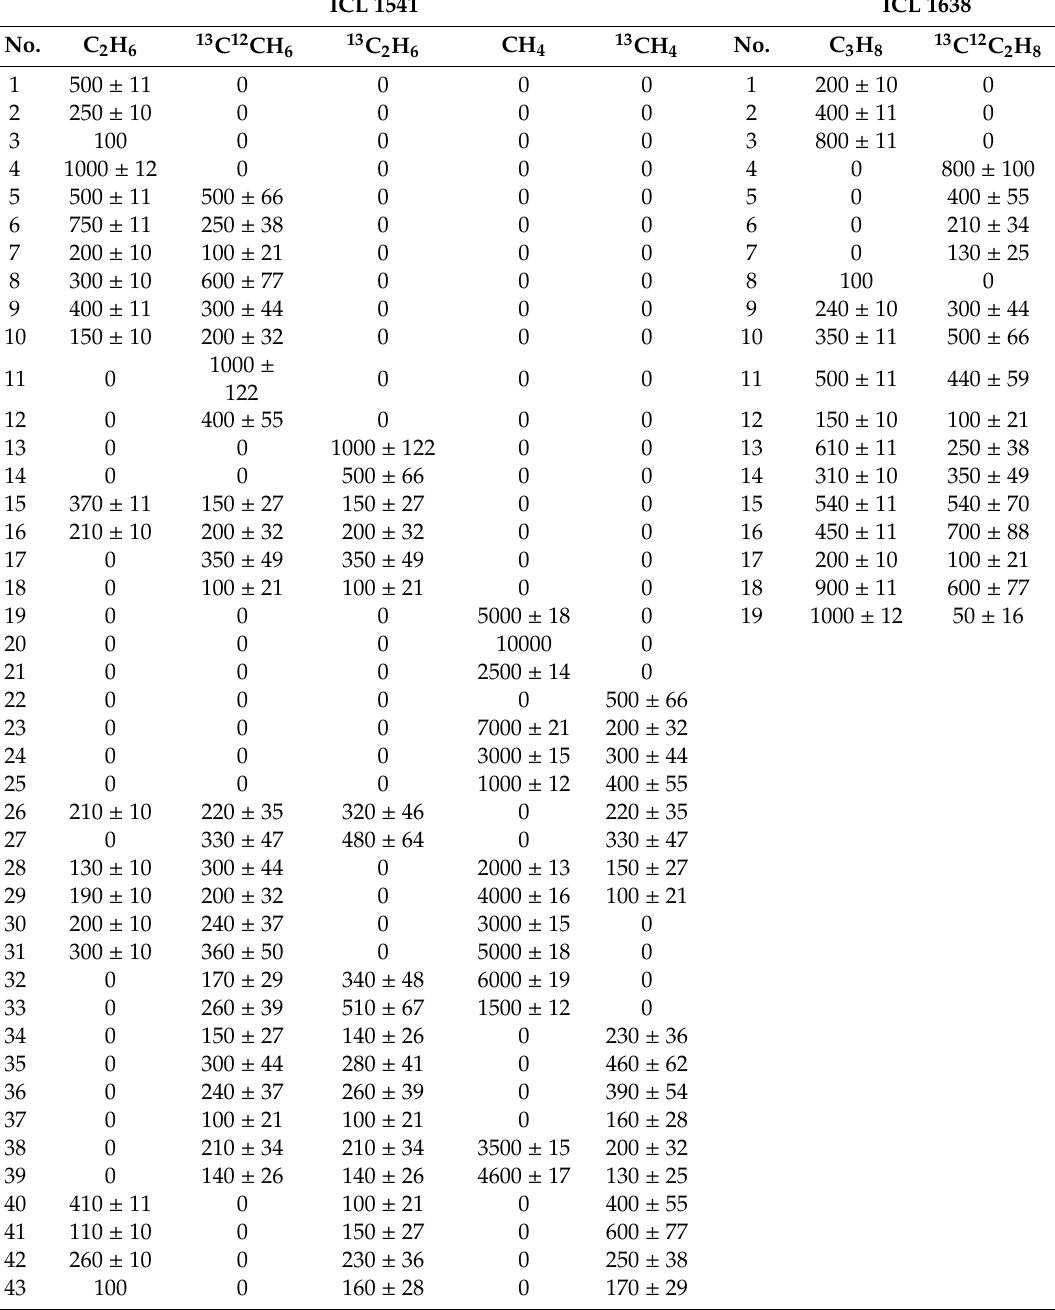
Table A1. Hydrocarbon concentrations of the gas mixtures in ppmv. The compounds CH 4 , C 2 H 6 , and C 3 H 8 are at NA. The uncertainties of the values were calculated from the purity of the sample gas and the error of the pressure readings ( ± 1 hPa) by error